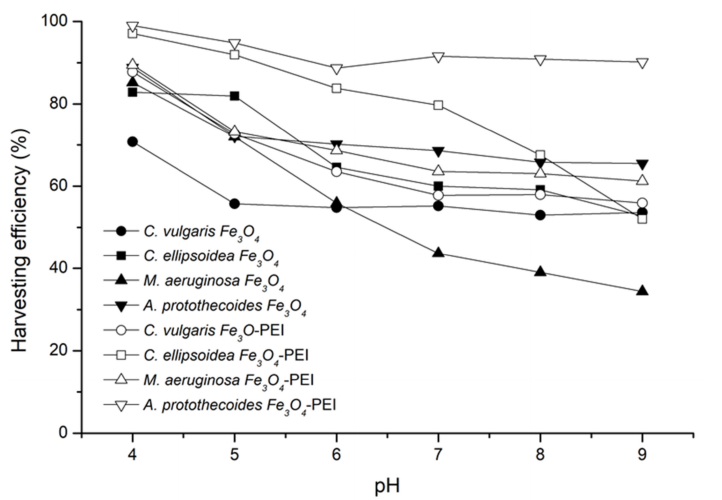
Figure 7. Harvesting efficiencies of uncoated and PEI-coated Fe 3 O 4 NPs prepared at 20 ◦ C (10 mg) at different pH levels.